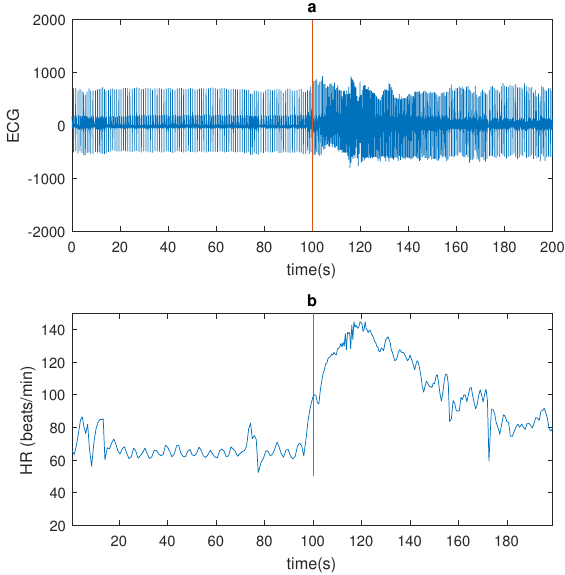
Figure 1. An example of a seizure (patient 4): ( a ) Electrocardiography (ECG) signal (bandpass filtered 1–40 Hz). ( b ) Heart rate (HR; red line indicates seizure onset as market by a clinician on the basis of electroencephalography